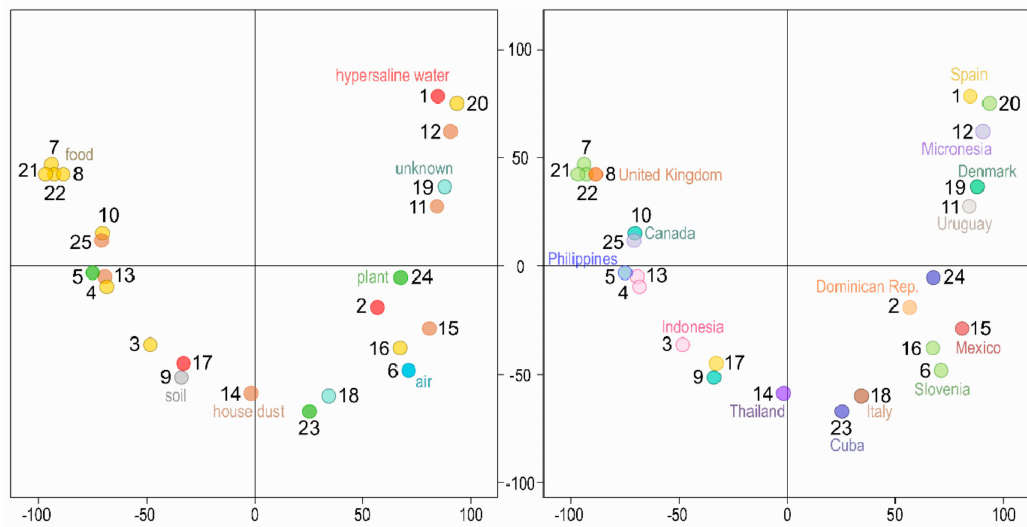
Figure 1. Clustering of the Wallemia mellicola genomes. Principal component analysis of single nucleotide polymorphisms (SNP) data estimated by comparing 25 sequenced genomes to the reference genome. The genomes are represented by circles, the color of which corresponds to the habitat (left) or sampling location (right) of the sequenced strains. The first two axes explain 23.7% ( x axis) and 8.80% ( y axis) of variation.